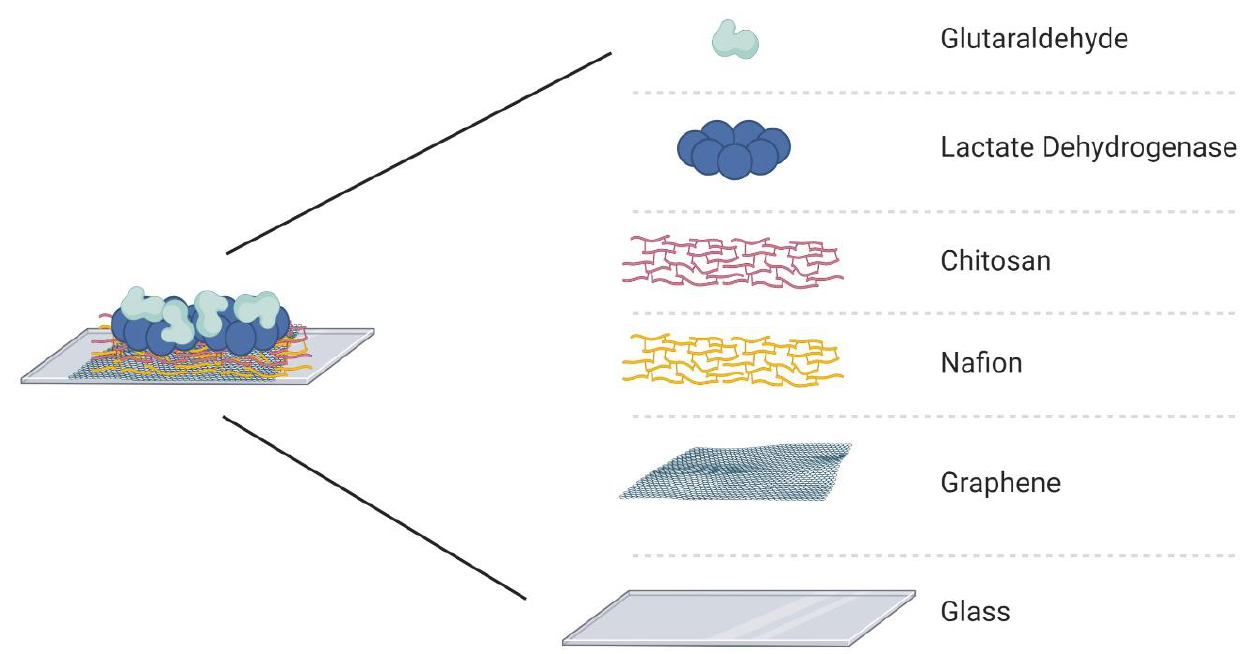
Figure 2. Immobilization matrix to support the enzyme (lactate dehydrogenase) on the surface of the active layer (graphene) of the GFET biosensor.